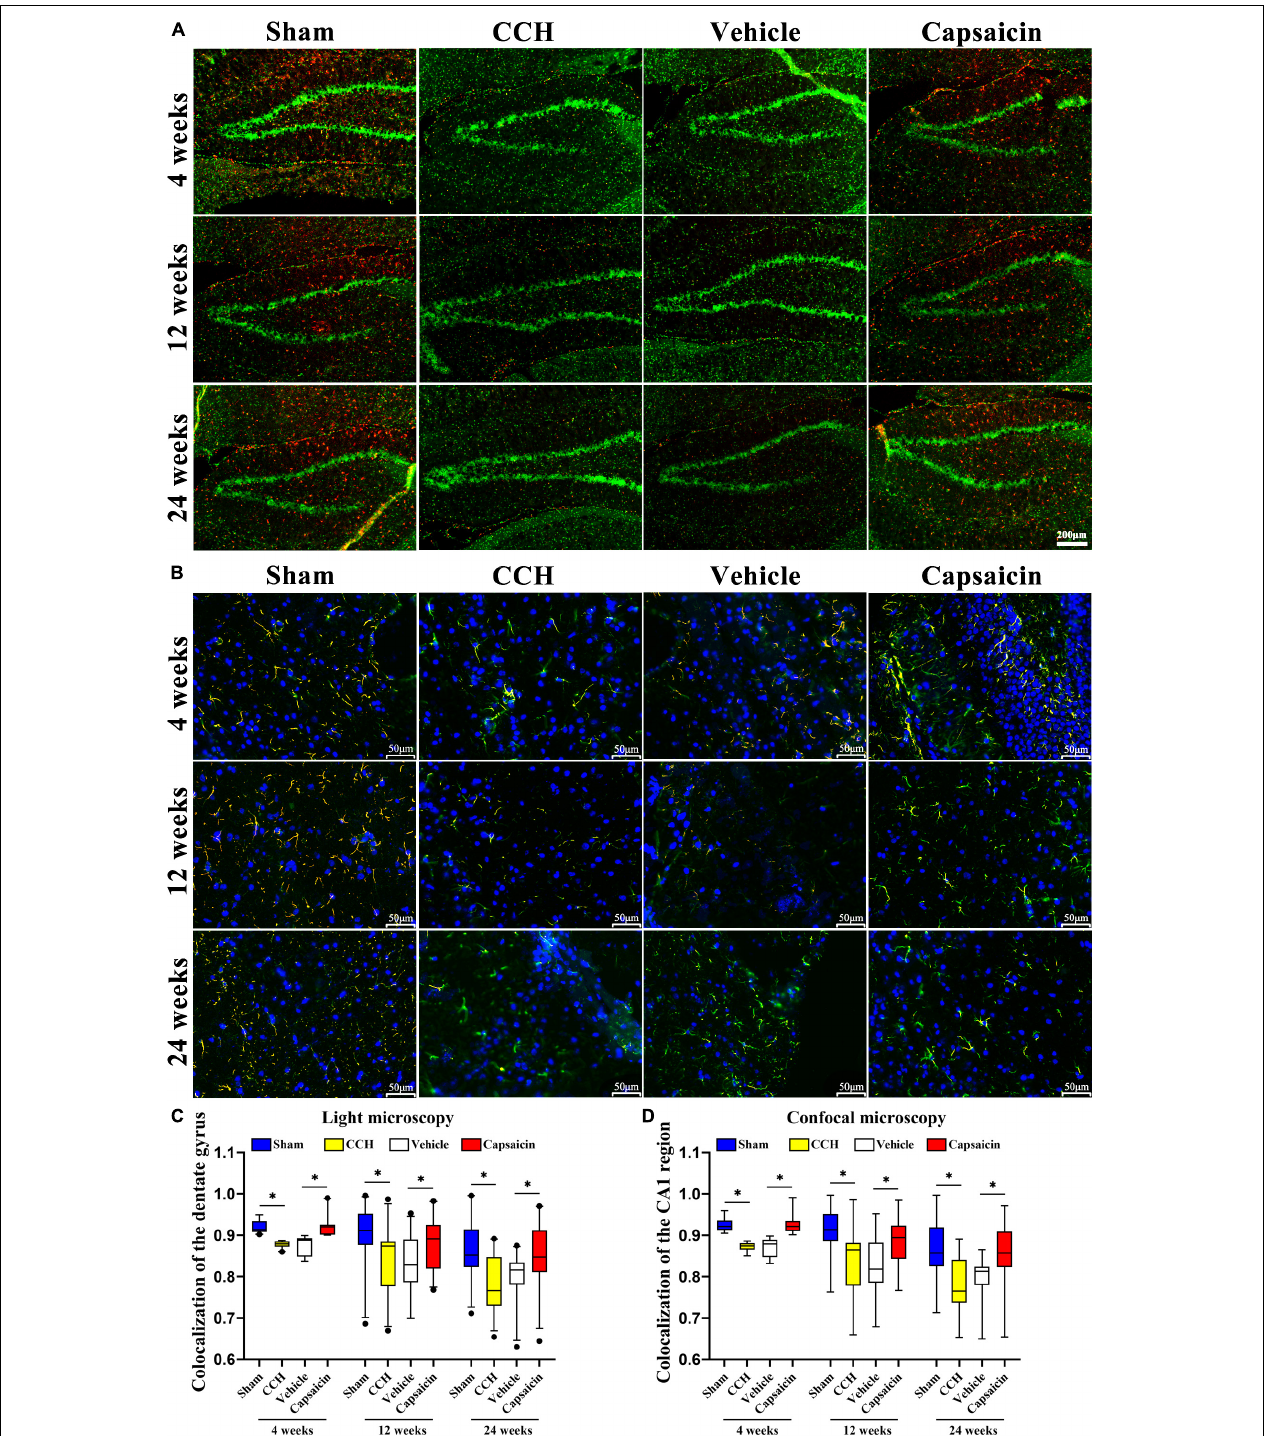
FIGURE 3 | The reduced ER-mitochondria colocalization in CCH rats is reversed by capsaicin. (A) Representative light micrographs of ER-mitochondria contacts in the dentate gyrus of the hippocampus at each time point in each group. MAMs were measured by determining ER and mitochondria colocalization using ImageJ through immunostaining for PDI and TOM20 to label the ER (red) and mitochondria (green), respectively, and merged signals indicate colocalization (orange). Scale bar is 200 µ m (100x). (B) Representative confocal images of ER-mitochondria contacts in the CA1 region of the hippocampus. Nuclei appear in blue. The scale bar represents 50 µ m (200x). (C) Boxplot showing the colocalization values in the hippocampus ( n = 22 – 29 per group). (D) Boxplot showing the colocalization values in the hippocampal CA1 region of different groups ( n = 66 – 87 per group). Data are presented as the mean ± SD. * P < 0.05. Data were analyzed by one-way ANOVA followed by the post hoc LSD